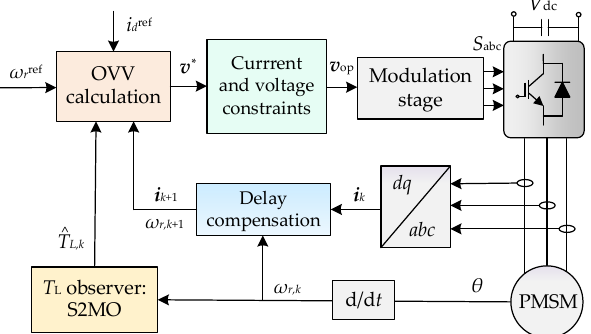
Figure 2. Block diagram of the second-order sliding mode load torque observer.